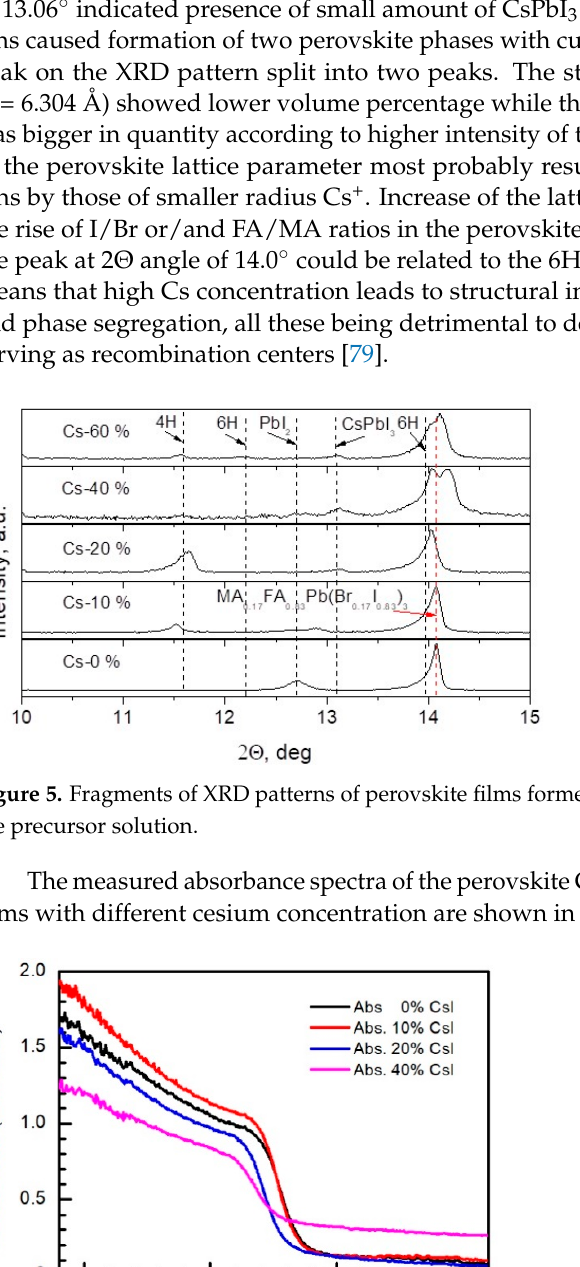
Figure 5. Fragments of XRD patterns of perovskite films formed with different concentration of Cs in the precursor solution.